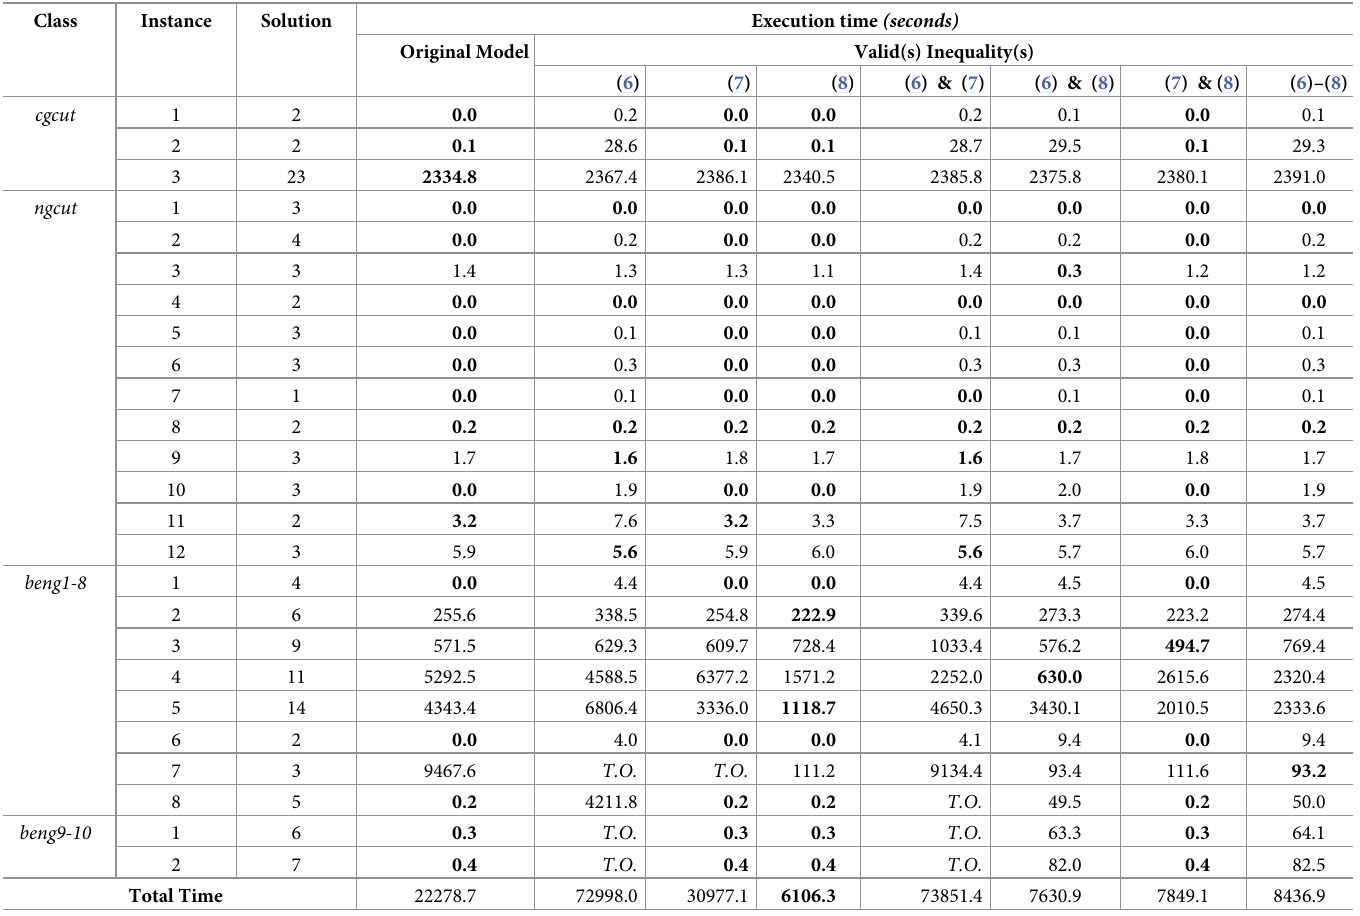
Table 8. Experimental results for cgcut , ngcut , and beng instances without rotations.